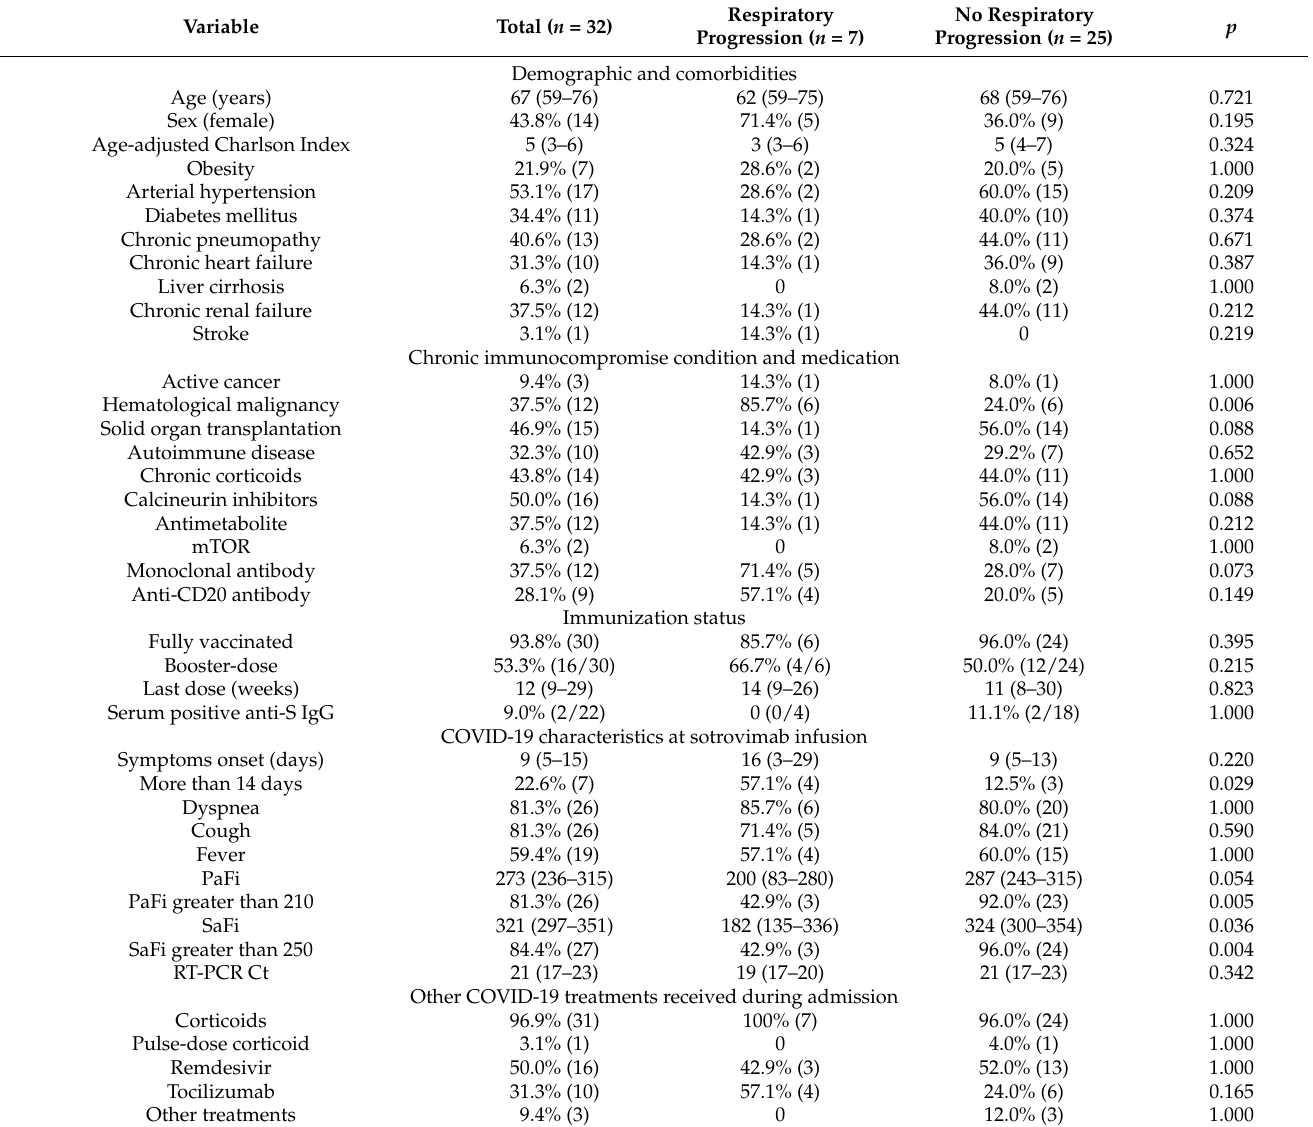
Table 1. Patients’ characteristics among those with and without respiratory